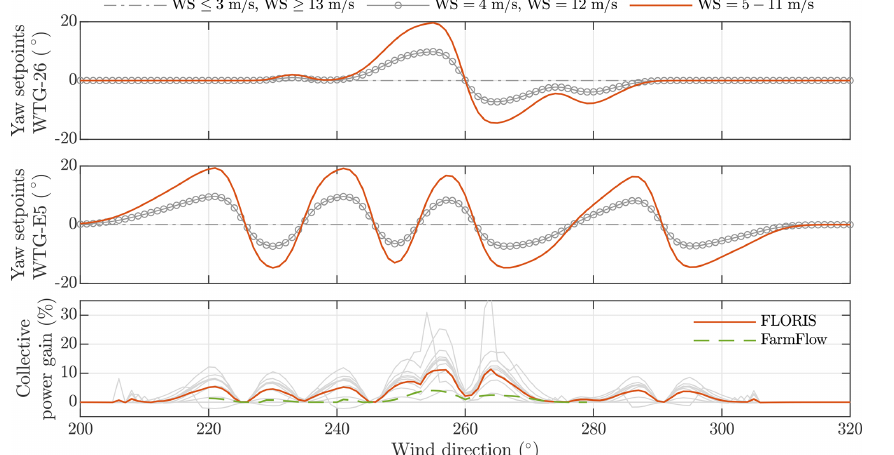
Figure 6. The turbine yaw setpoints for WTG 26 and WTG E5 for a freestream turbulence intensity of 7.5%. The yaw angles hold constant values for wind speeds of 5 to 11ms − 1 . At lower and higher wind speeds, the setpoints are interpolated to a yaw angle of γ = 0 ◦ at 3 and 13ms − 1 , respectively. The collective power gain of WTG 26, WTG E5, and the downstream turbine (WTG 10, 11, 12, or 31) averaged over all wind speeds is shown as the solid orange line (FLORIS) and the dashed green line (FarmFlow) in the bottom plot. The gray lines therein represent the predicted gains for one wind speed by